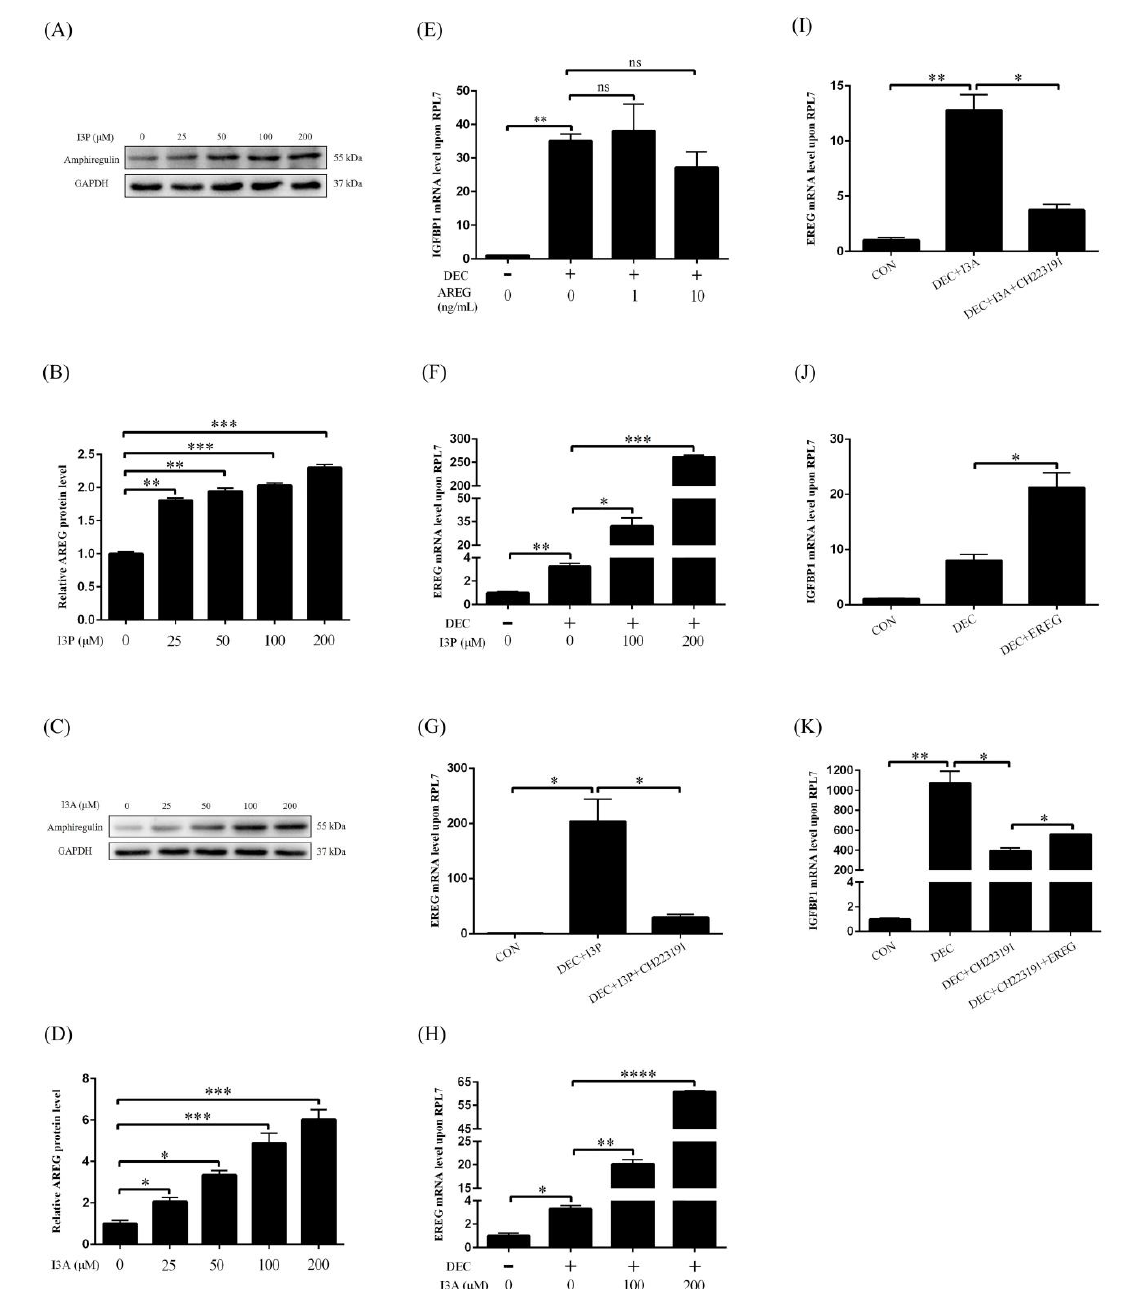
Figure 5. I3P and I3A regulate human in vitro decidualization via the AHR-EREG pathway. ( A , B ) AREG protein level after stromal cells were treated with different concentrations of I3P for 24 h. ( C , D ) The protein level of AREG after stromal cells were treated with different concentrations of I3A for 24 h. ( E ) RT-qPCR analysis of IGFBP1 mRNA level after stromal cells were treated with AREG. ( F ) The mRNA level of EREG after stromal cells were treated with I3P. ( G ) RT-qPCR analysis of the mRNA level of EREG after stromal cells were treated with I3P and CH223191. ( H ) The EREG mRNA level after stromal cells were treated with I3A. ( I ) RT-qPCR analysis of the mRNA level of EREG after stromal cells were treated with I3A and CH223191. ( J ) IGFBP1 mRNA level after stromal cells were treated with EREG. ( K ) RT-qPCR analysis of the mRNA level of IGFBP1 after stromal cells were treated with CH223191 and EREG. CON, control; DEC, decidualization; AREG, amphiregulin; EREG, epiregulin; ns, no significance. *, p < 0.05; **, p < 0.01; ***, p < 0.001; ****, p <